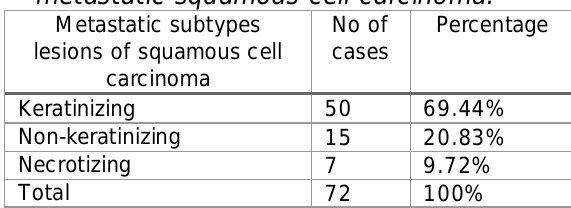
Table No: 3 Disribution of subtypes of